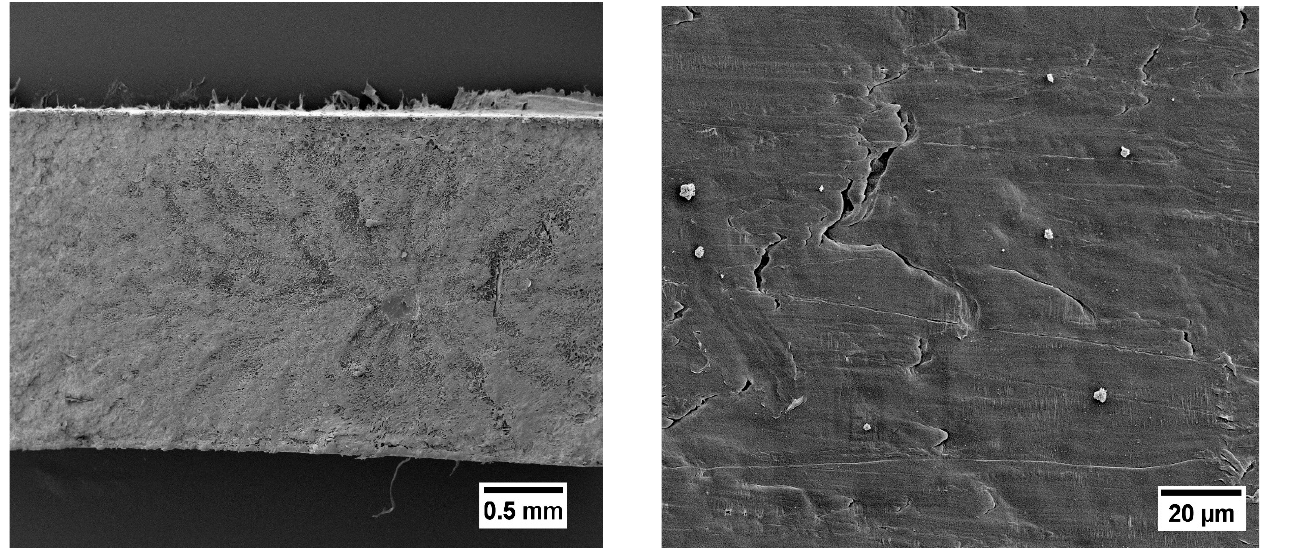
Figure 6. SEM images showing the cross-section of a broken mechanical test specimen composed with CNF-PSA/HDPE .